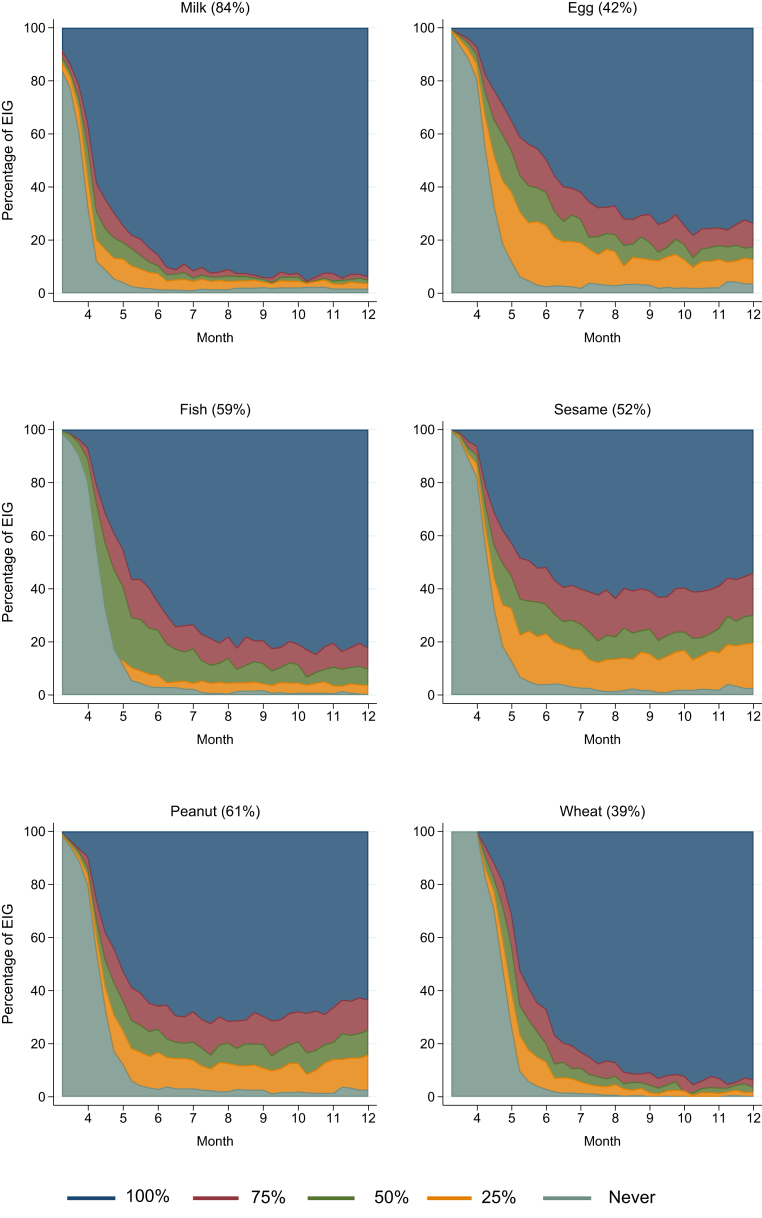
Adherence with introduction of allergenic foods in the EIG up to 1 year of age. The figure presents the relative proportions of the EIG consuming 100%, 75% (the per-protocol threshold), 50%, or 25% or not having started consuming each of the 6 early introduction foods from enrollment through 12 months of age. The food-specific per-protocol adherence percentage (among those whose food-specific adherence status was evaluable) is shown in parentheses.